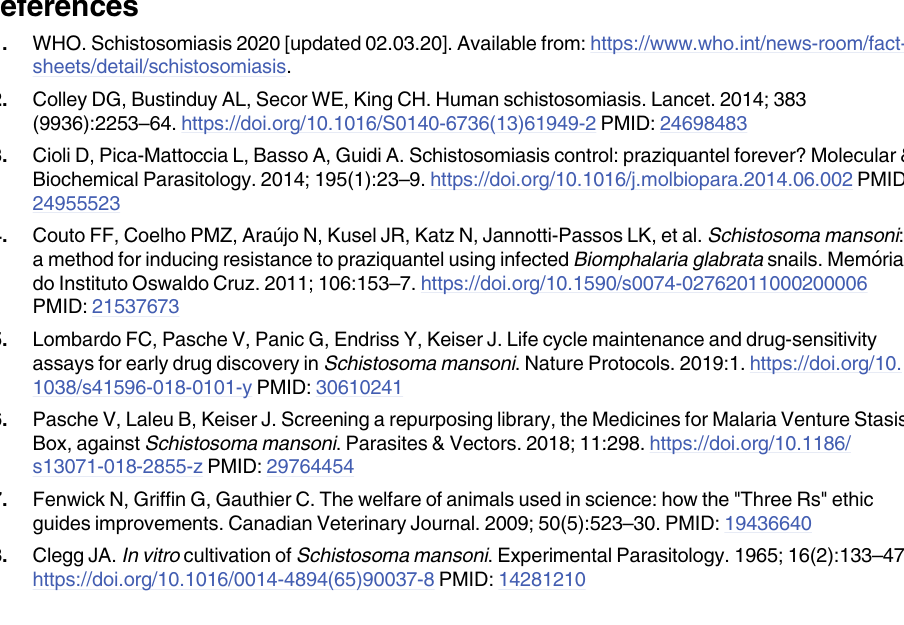
(TIF) S8 Fig. Adult couples of S . mansoni developed in vivo for 49 days and incubated free of drugs for 24 hours. Amplification: 40x. Scale bar: 1 mm. (TIF) S9 Fig. S . mansoni developed in vivo for 21 days A: male and two undeveloped worms 100X, B: undeveloped worms100X. U: undeveloped worm. Scale bar: 200 μ m. (TIF) S10 Fig. S . mansoni developed in vivo for 28 days. Amplification: 100x. Scale bar: 200 μ m.